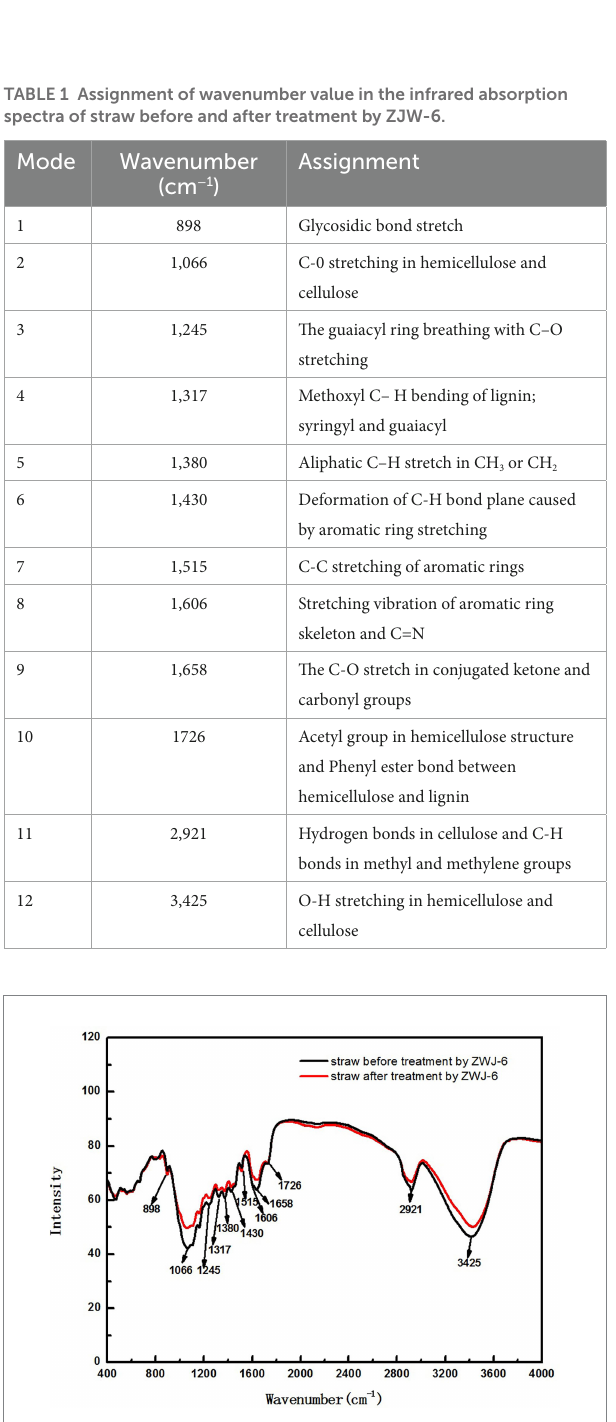
FIGURE 9 The infrared absorption spectra of straw before and after treated by